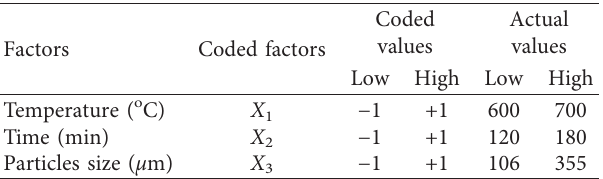
Table 1: Experimental level for central composite design (CCD) in coded and actual